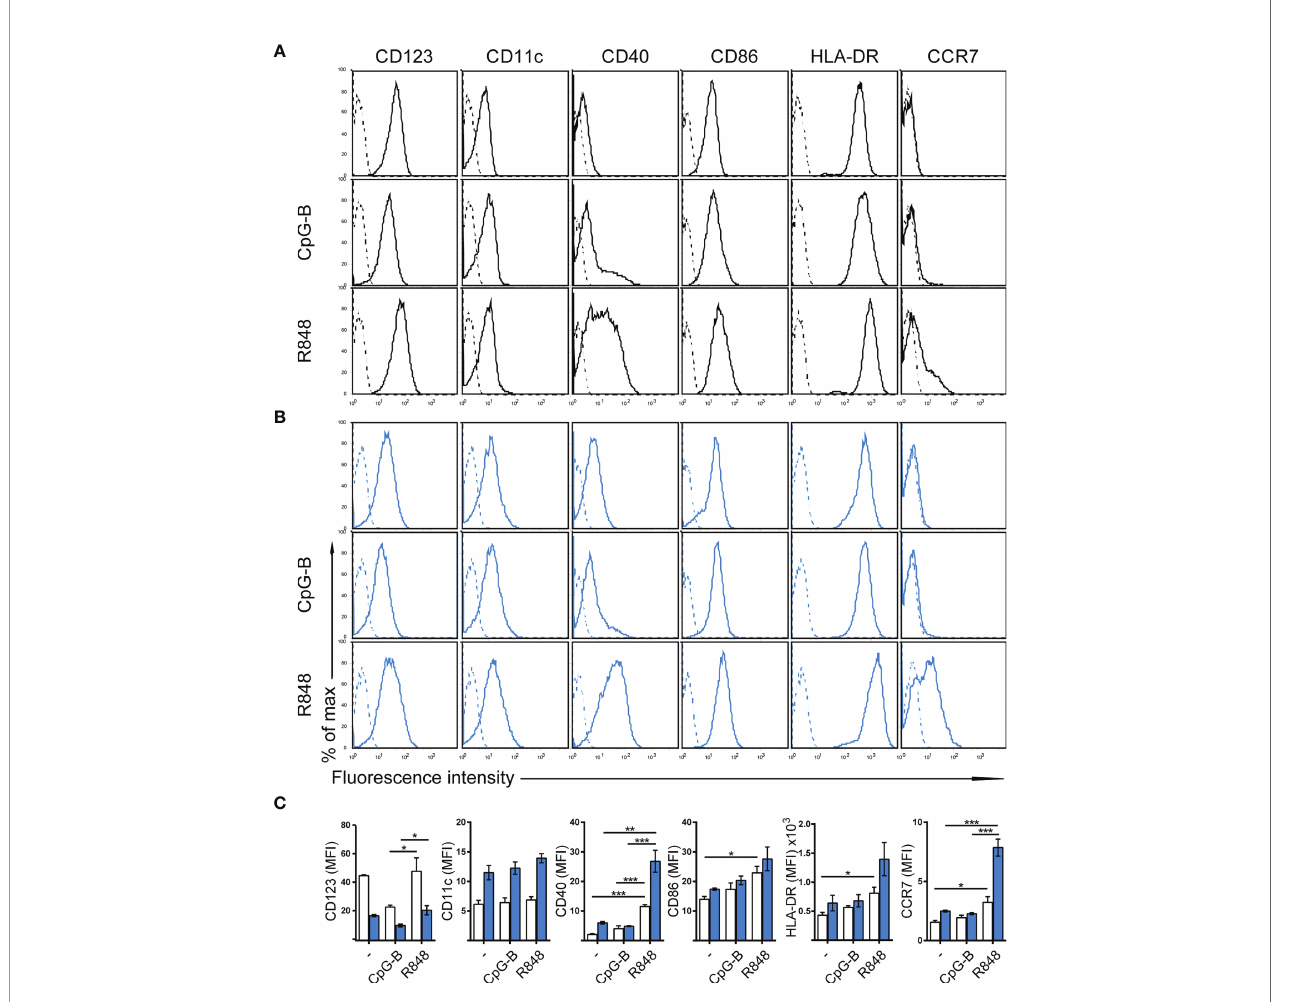
FIGURE 1 | Phenotypic characterization of human CAL-1 cells and CCR7 induction upon exposure to GM-CSF and maturation by R848. (A) Surface expression of CD123, CD11c, CD40, CD86, HLA-DR and CCR7 (solid lines) on CAL-1 cells that were stimulated or not for 18-19h with the TLR9 ligand CpG-B ODN 2006 (1 m M) or the TLR7/8 ligand Resiquimod R848 (10 m g/ml). Representative fl ow cytometry histograms derived from one out of three independent experiments are depicted. Unstained cells or isotype-matched controls for CCR7 stainings are shown as dashed lines. (B) Surface expression of CD123, CD11c, CD40, CD86, HLA-DR and CCR7 on CAL-1 cells cultured for 3 days in the presence of 10ng/ml GM-CSF. Where indicated, these GM/CAL-1 cells were in addition matured by either CpG-B or R848 as in (A) . Representative fl ow cytometry histograms derived from one out of three independent experiments are depicted. (C) Quantitative analysis of surface markers on CAL-1 (white bars) and GM/CAL-1 (blue bars) cells. Mean values ± SEM of the 3 independent experiments (A, B) are